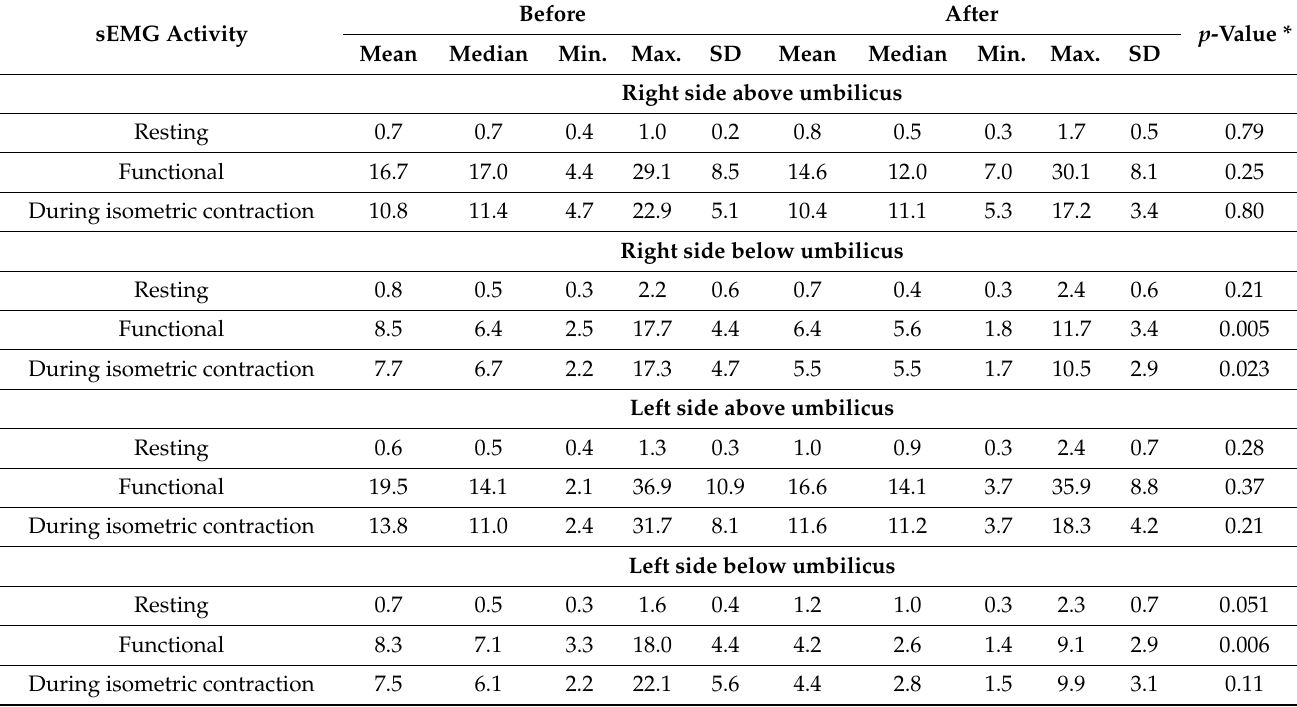
Table 4. sEMG measurements before and after the application of non-stretch tapes in the sham KT group. sEMG